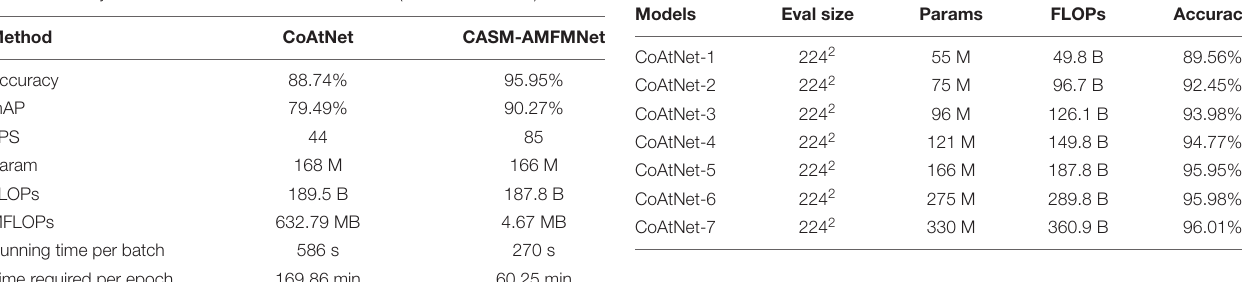
TABLE 7 | Comparison result of different groups.